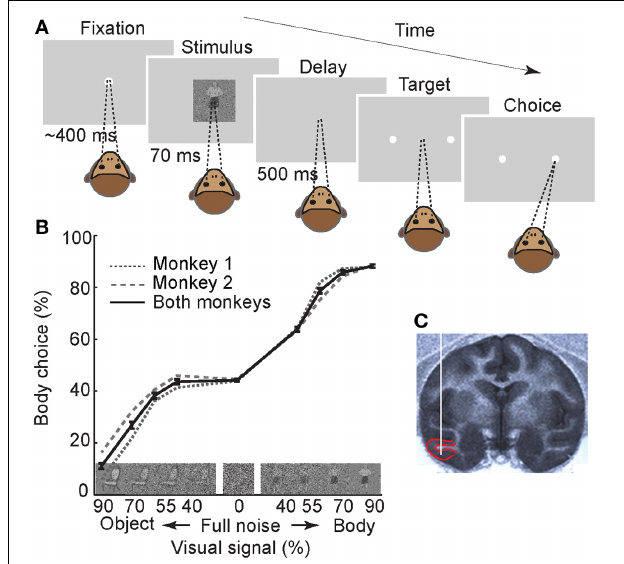
FIGURE 1 | Experimental paradigm and behavioral results. (A) Monkeys were trained to perform a two-alternative forced-choice body/non-body categorization task. The stimulus set contained 720 photographs of body and non-body images, in four different signal levels, and 90 full-noise stimuli. For illustration only, stimulus is depicted here with a relatively large size compared to the monitor screen. Numbers represent the duration of each epoch. (B) Monkeys’ performance. Images on the X-axis are examples of noisy stimuli in different signal levels. The error bars represent the ± 1 standard error of the mean (s.e.m.) across recording sessions ( n = 61). (C) Sagittal section of the MRI at the anteroposterior level of 16 in monkey 1. Red lines depict the boundaries of recording area (lower bank of STS and TE). White vertical line schematically represents the inserted